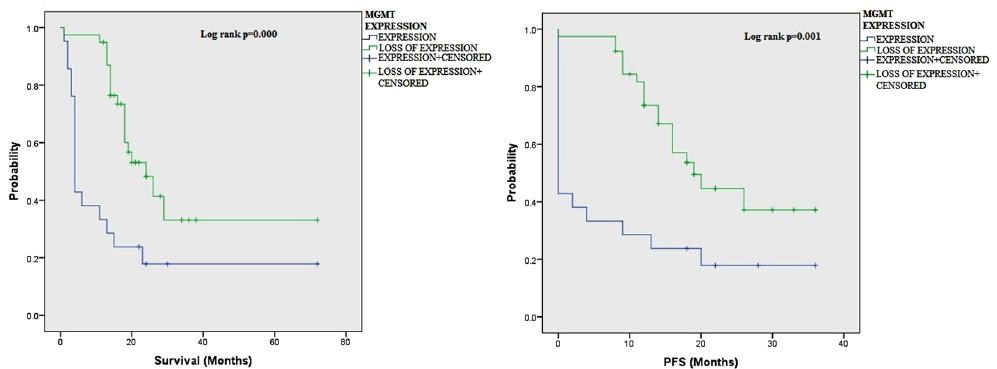
Figure 3. Association of MGMT protein expression with overall survival (OS) and Progression Free survival (PFS) of glioma patients as shown by KM